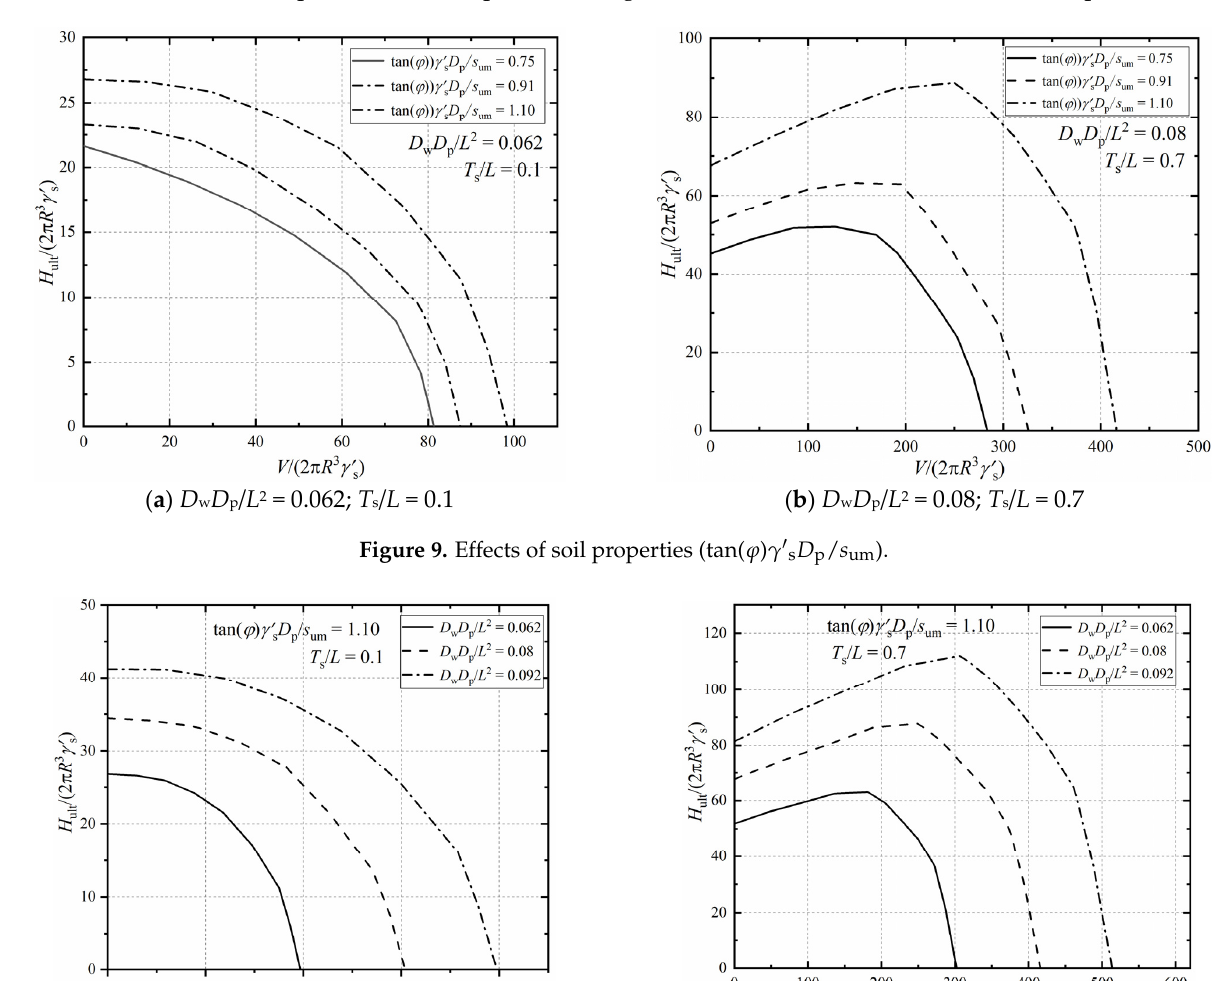
Figure 10. Effects of wheel diameter and pile embedment depth ( D w D p / L 2 ).